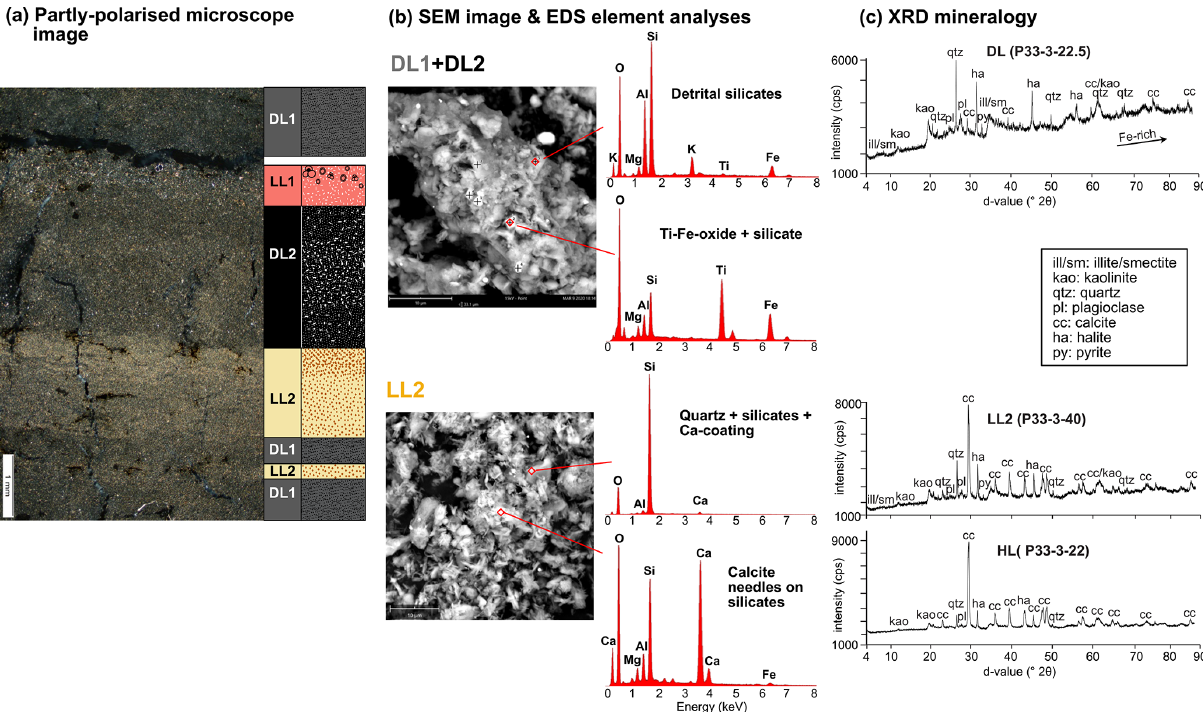
Figure 3. Microscopic, elemental and mineralogical characterization of sublayers from core P33. (a) Micro-facies and mineralogy of a typical sublayer succession in cores P33. Left to right: part-polarized microscope image and schematic log of sublayers succession DL1–LL2–DL2– LL1. (b) SEM images of powdered dark (DL1 + DL2) and light sublayers (LL2) with EDS elemental identification. (c) Mineralogical assemblage of powdered DL, LL and HL samples using XRD scans (from 4 to 85 ◦ 2 θ ). In sample DL (P33-3-22.5), the increase in the intensity baseline towards higher angles is due to the presence of an Fe-rich phases, probably